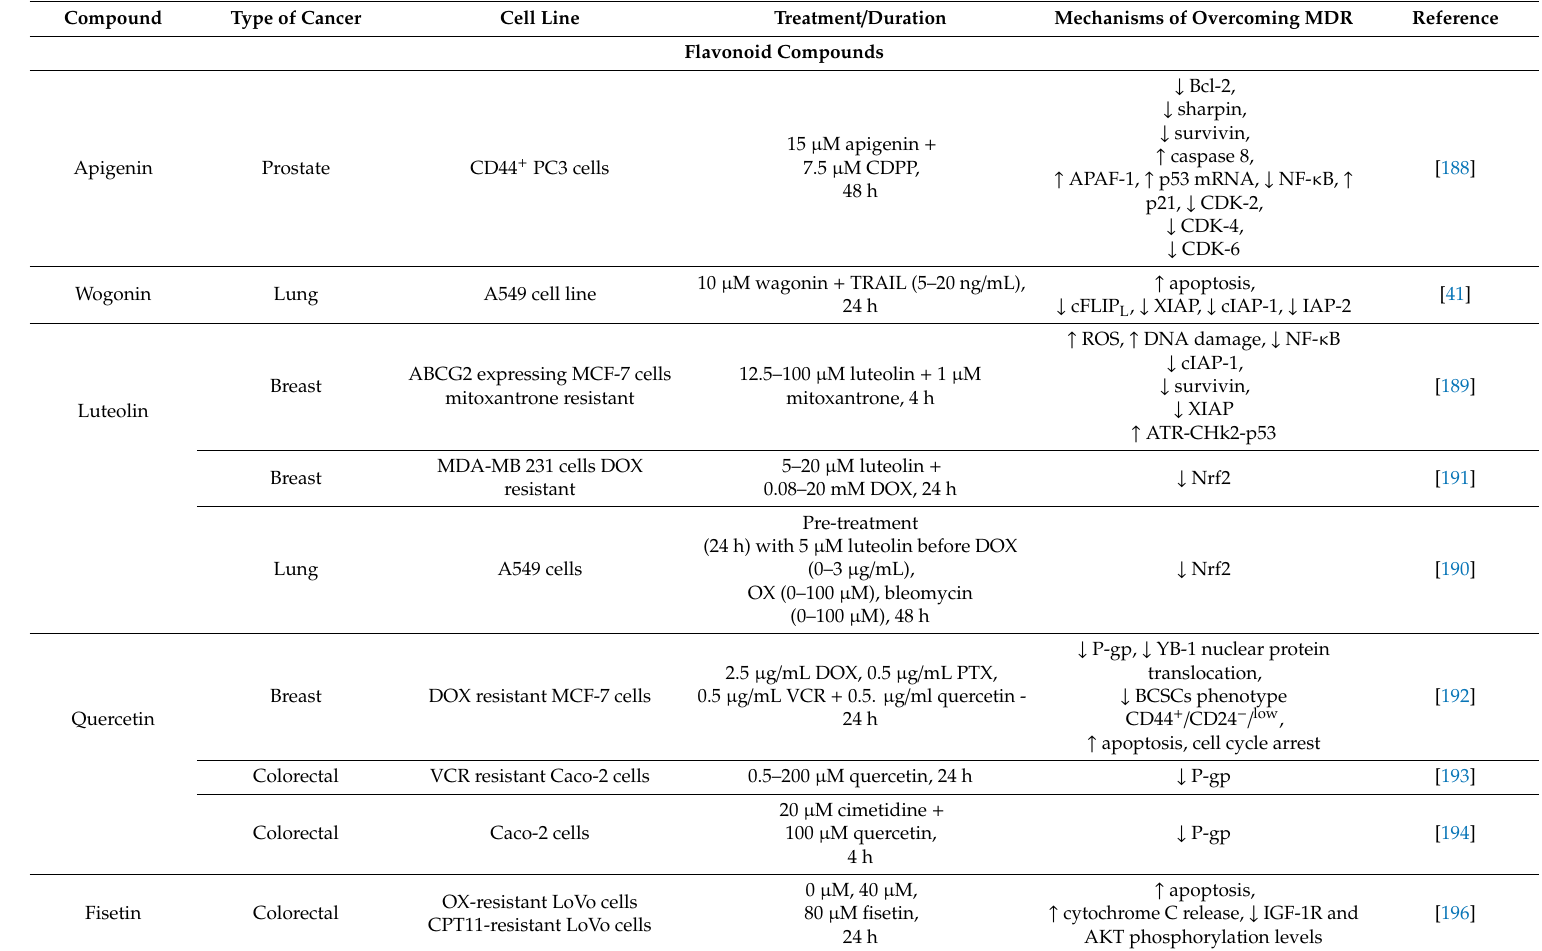
Table 2. Summary of in vitro